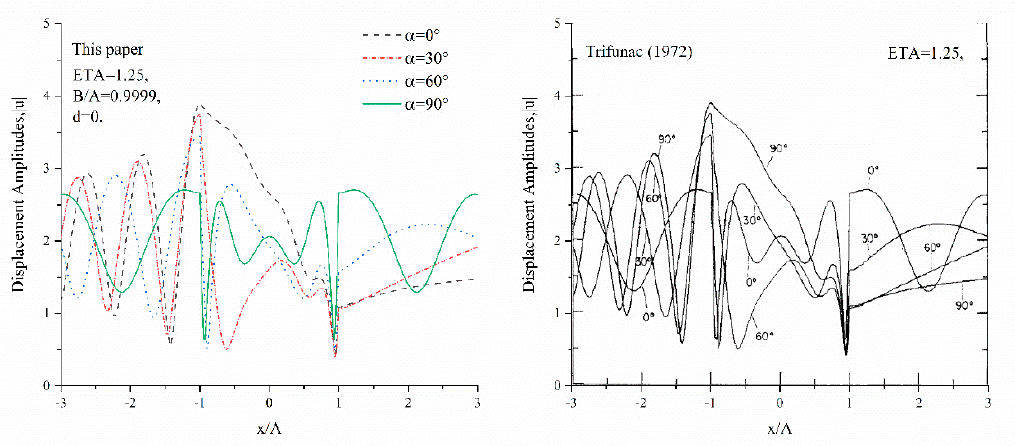
Figure 4. Comparison with the case of a semi-circular canyon by Trifunac [12].